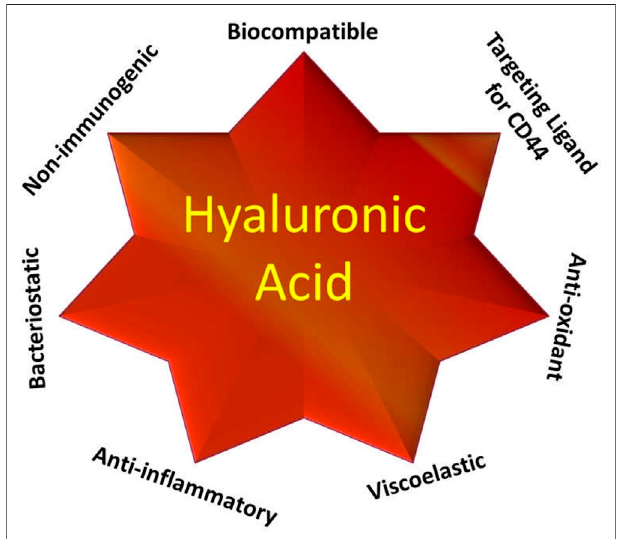
FIGURE 1 | Potential of hyaluronic acid in pharmaceutical drug